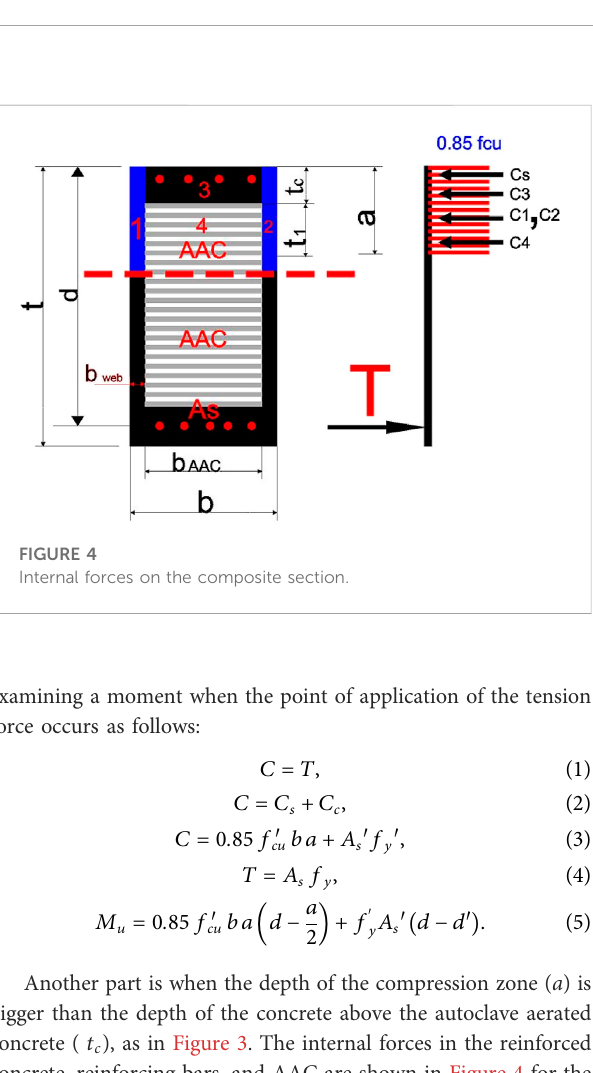
Theoretical stress – strain in the composite section when t c < a .